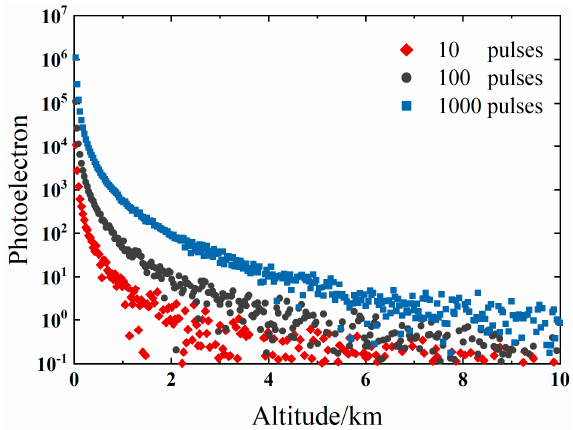
Figure 1. Simulation results of cumulative pulse signals with